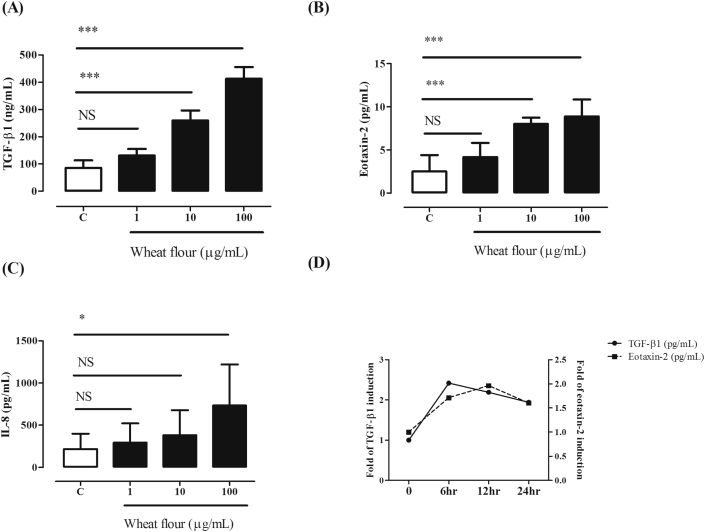
Wheat-induced TGF-β1 (A), eotaxin2 (B) and IL-8 (C) productions from HAECs with their kinetic changes in a time-dependent manner. P values were analyzed by one way ANOVA with Tukey post hoc test. *P < 0.05, **P < 0.01 and ***P < 0.001 compared between the indicated groups; NS, not significant. IL-8, interleukin-8; TGF-β1, transforming-growth factor β1